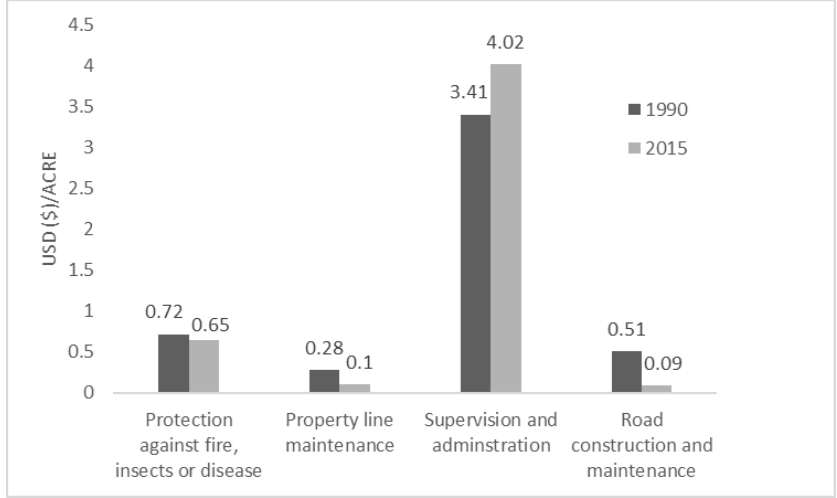
Figure 7. Mean expenditures for Other Management Activities of the entire sample .